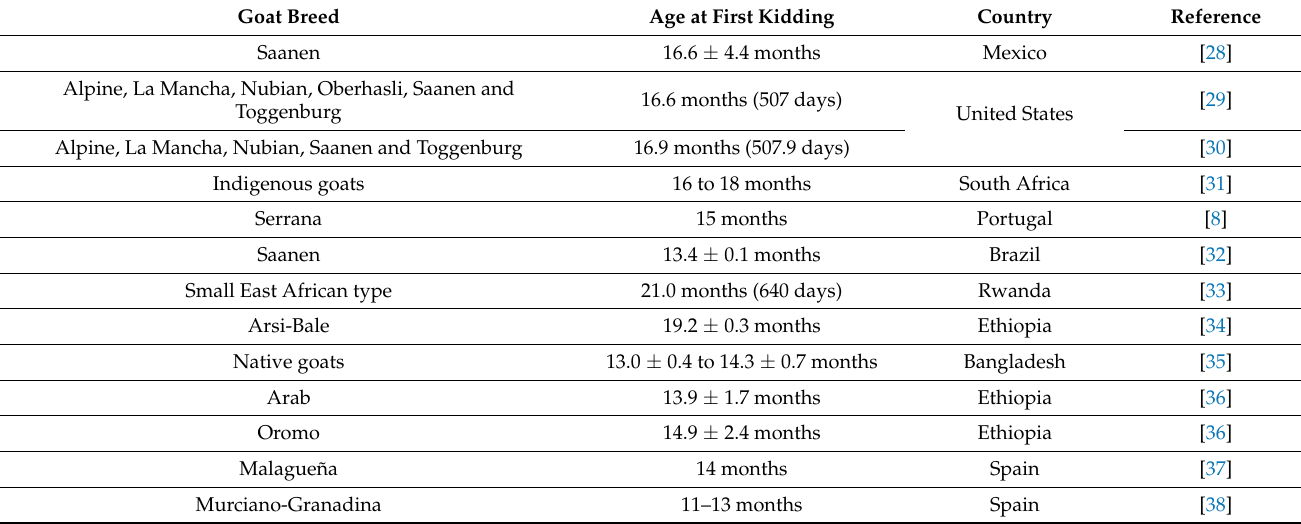
Table 5. Age at first kidding of different local goat